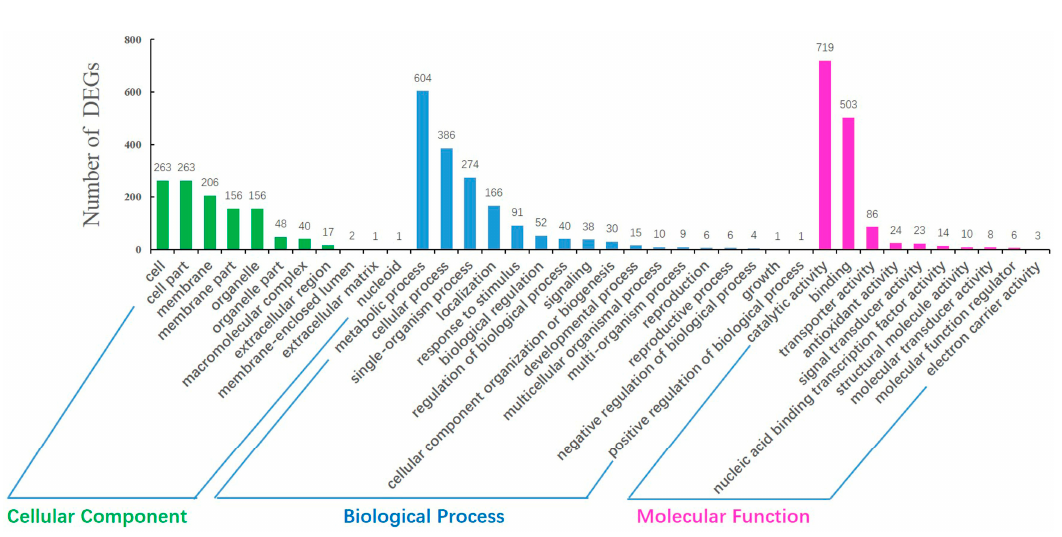
Figure 5. Gene ontology classification of DEGs in the H276A vs. H276B library.